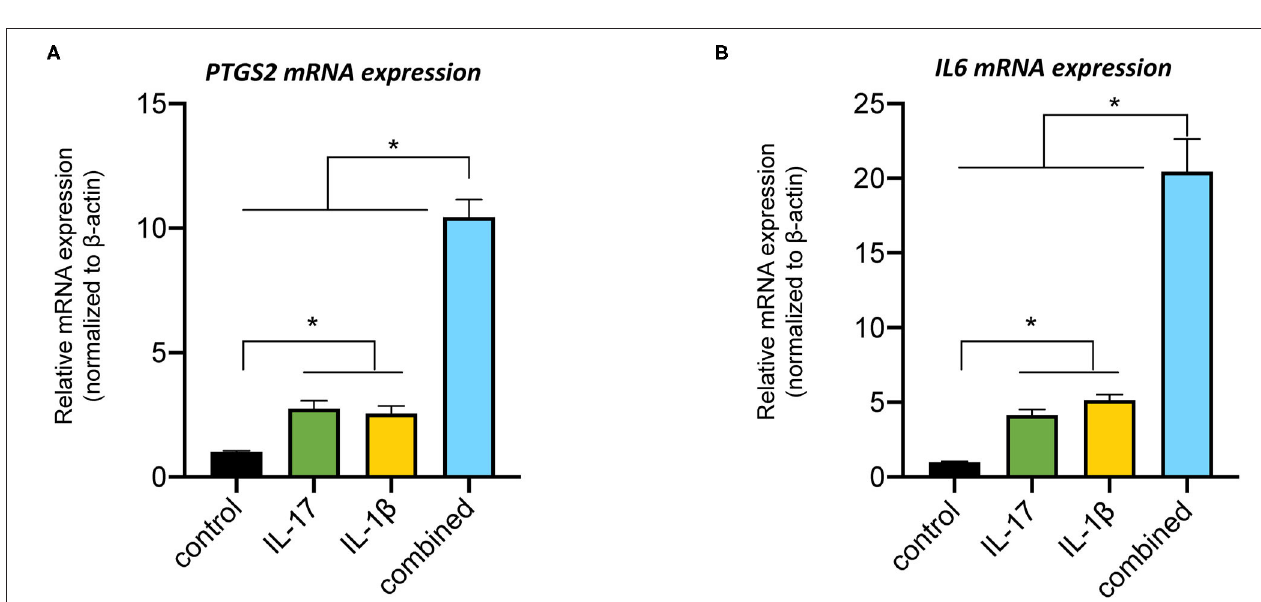
FIGURE 2 | Synergistic actions of interleukin-1 β (IL-1 β ) and interleukin-17 (IL-17) on the immune gene regulations in pPDLSCs. pPDLSCs were challenged with human recombinant IL-1 β (50ng/ml), recombinant IL-17 (50ng/ml), or both combined for 16h. Prostaglandin-endoperoxide synthase 2 (PTGS2) (A) and interleukin-6 (IL6) (B) mRNA transcripts were significantly elevated by the combined cytokine treatment indicating a synergistic effect. Error bars represent SDs. * p < 0.05.